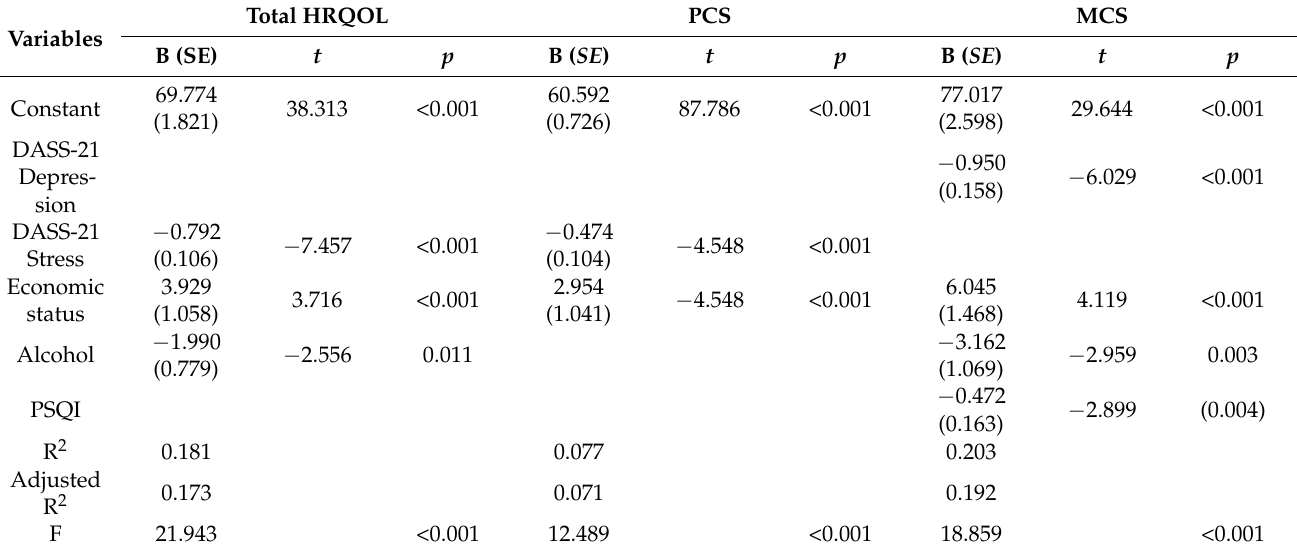
Table 4. Results of the stepwise multiple regression analysis for health-related quality of life ( N = 301).